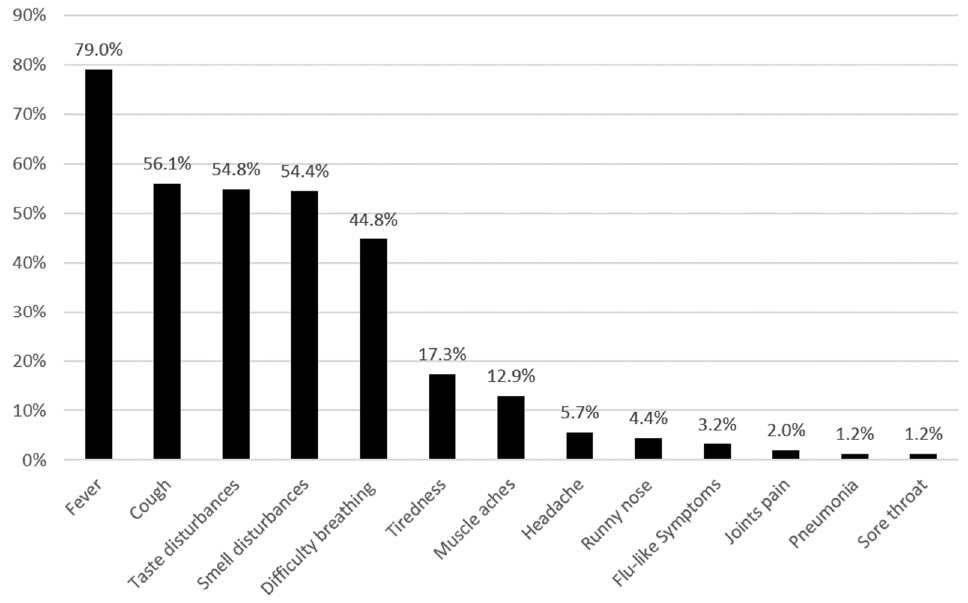
Figure 1. The most common symptoms recognized by patients with MS as indicative of COVID-19 illness (provided for the frequency greater than or equal to 1%).